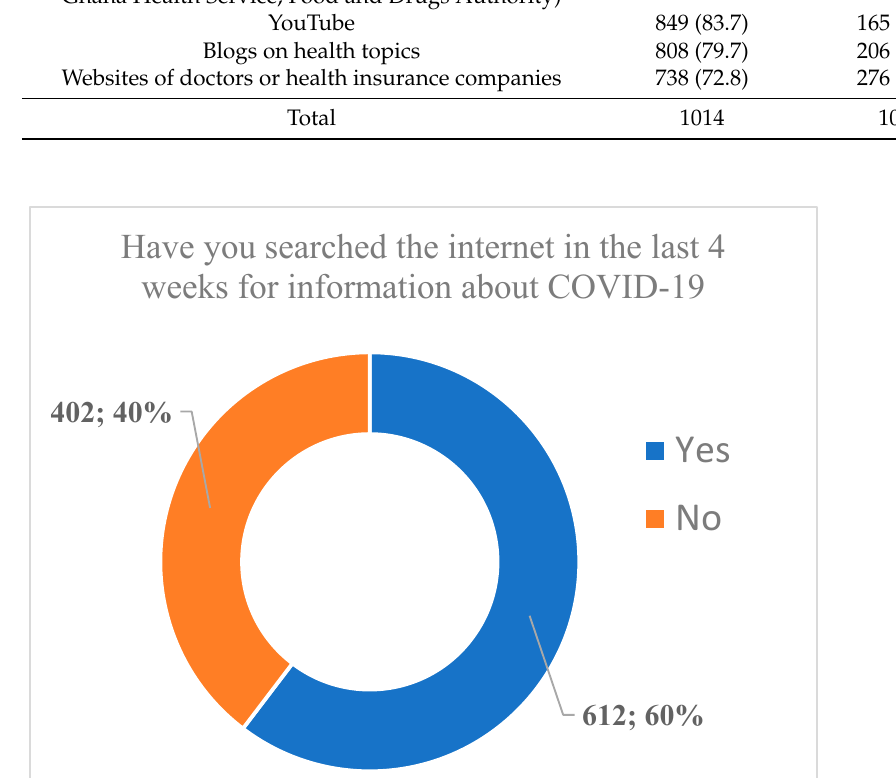
Figure 1. Responses on internet search in the last 4 weeks.